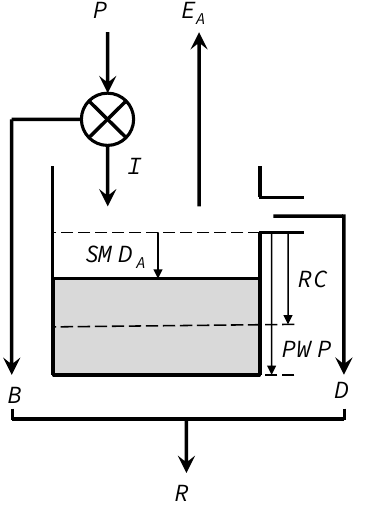
Fig. 5. Structure of the conventional recharge model.